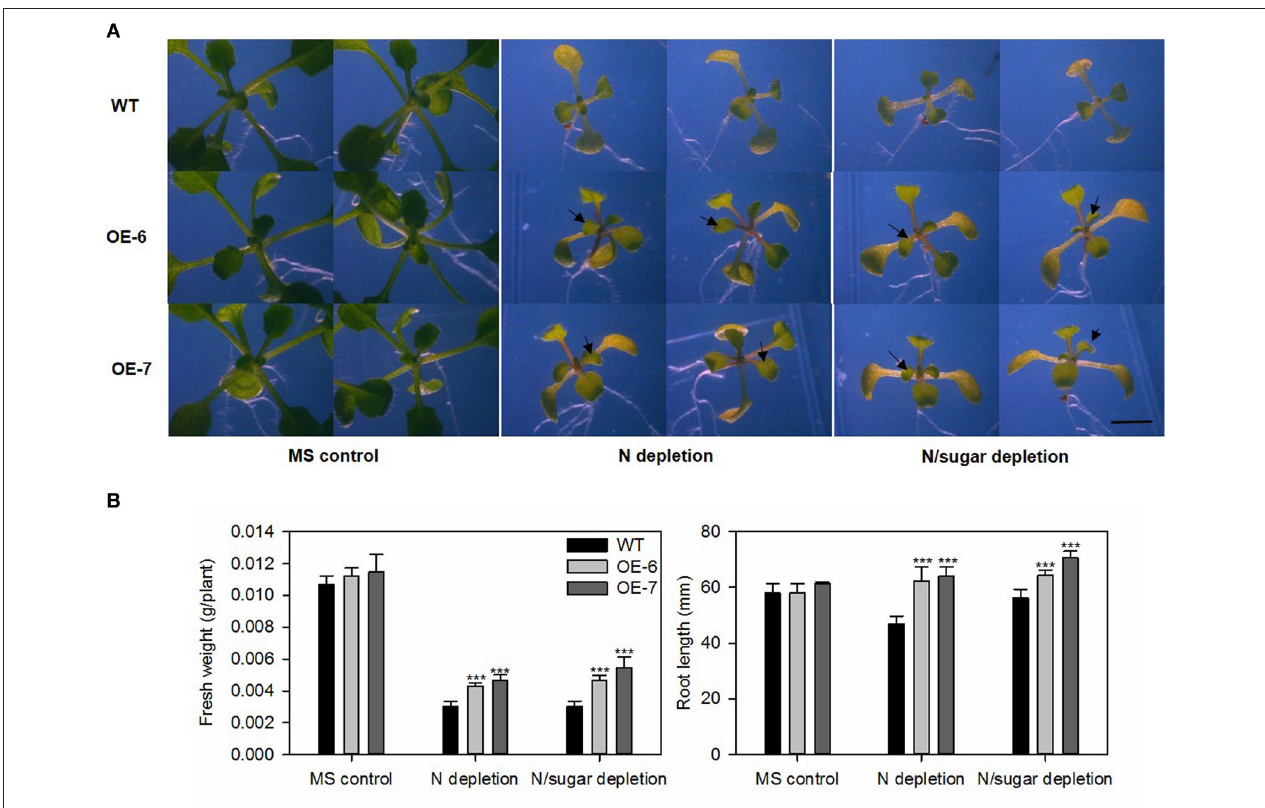
FIGURE 8 | Tolerance to nitrogen-starvation is enhanced by heterologous expression of MdATG8i . Five-day-old Arabidopsis seedlings were transferred to MS control, N-depleted, or N/sugar-depleted agar media. After 10 days under LD photoperiod, they were photographed (A) before recording fresh weights and root lengths (B) . Black arrowheads indicate newly emerged true leaves. Scale bar = 5 mm. Data are means ± SD of 15 replicates. * , ** or *** indicates the statistically significant differences determined by Student’s t -tests at P < 0.05, P < 0.01, or P < 0.001,